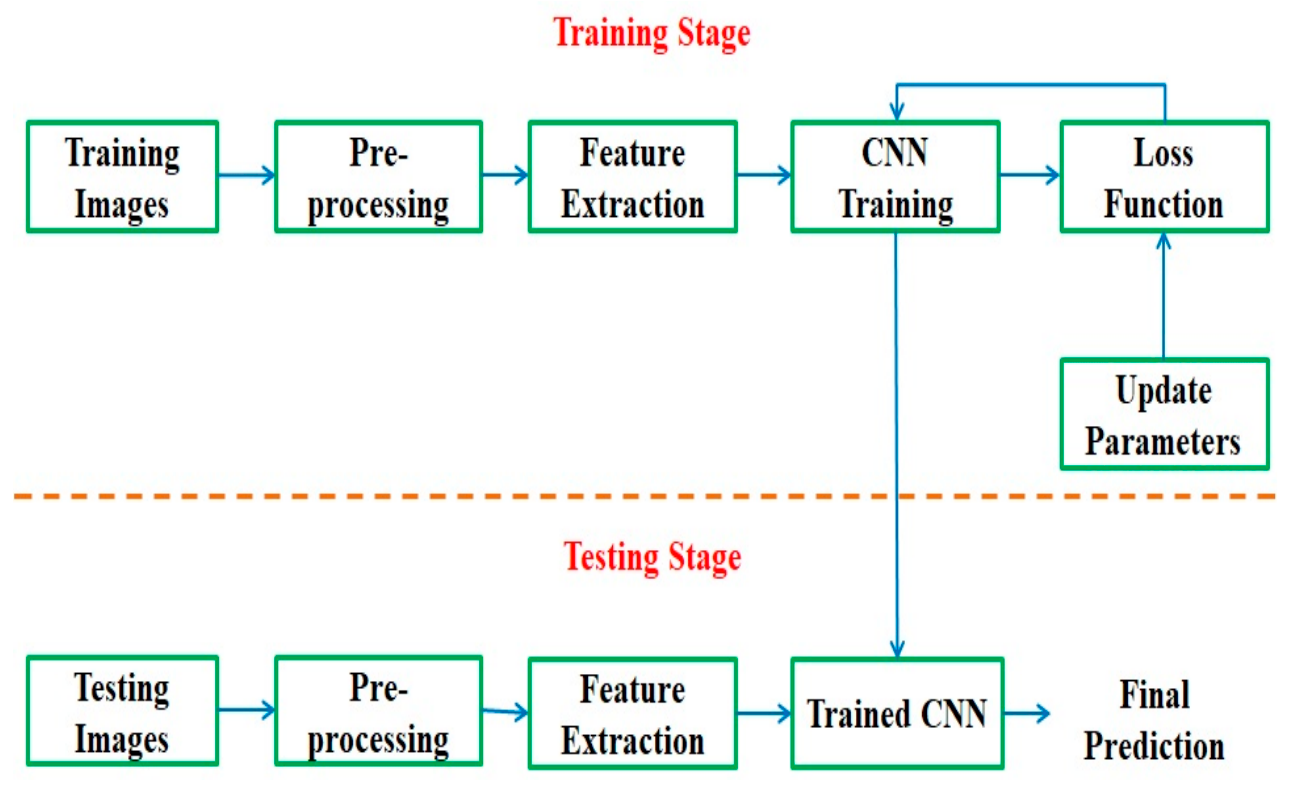
Figure 1. Proposed DCNN Framework for Brain Tumor Classification.